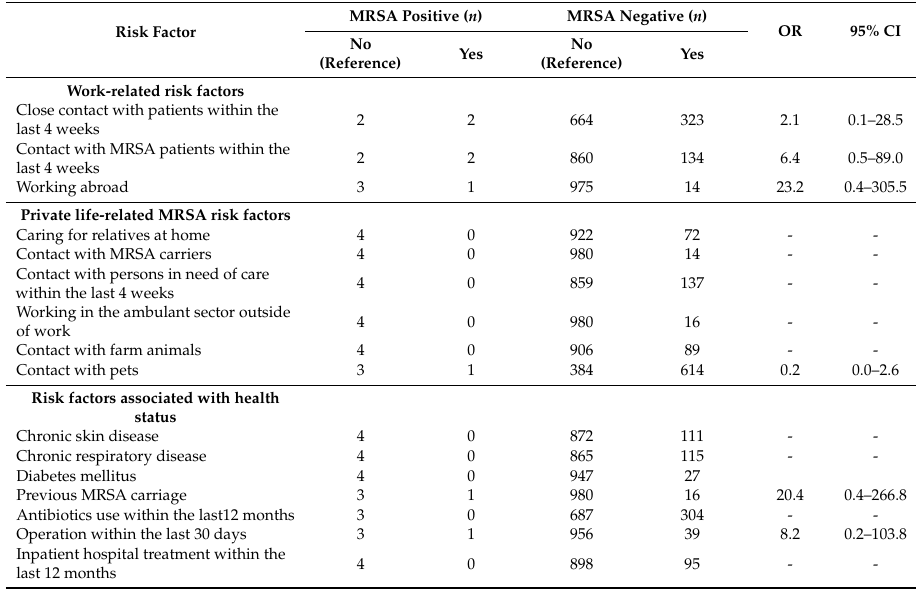
Table 2. Prevalence (odds ratios (ORs)) for MRSA risk